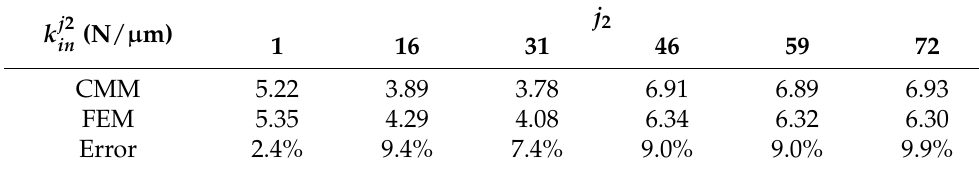
Table 1. Input stiffness along six branched chains of the 6-RRRR